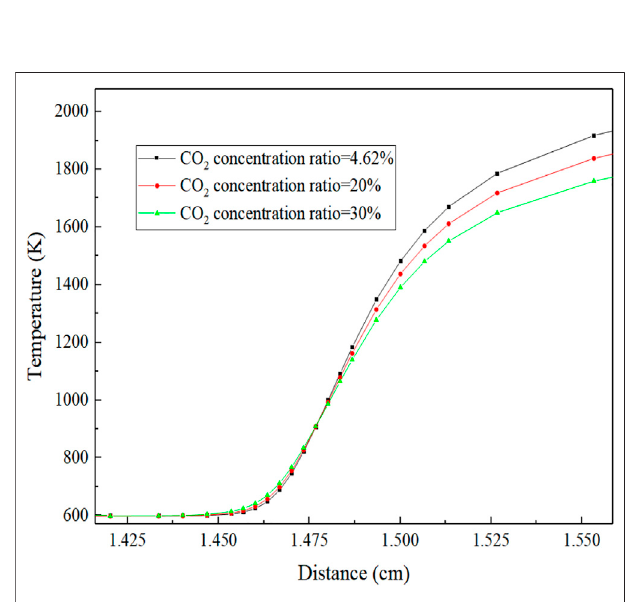
FIGURE 10 | Variation law of fl ame propagation speed with preheating temperature.